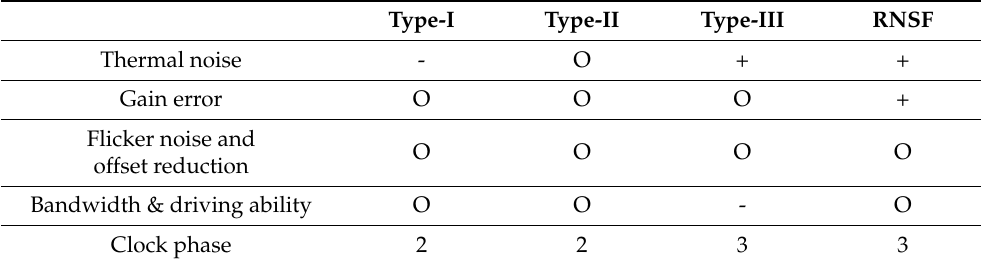
Table 1. Performance comparison of RNSF and CDS